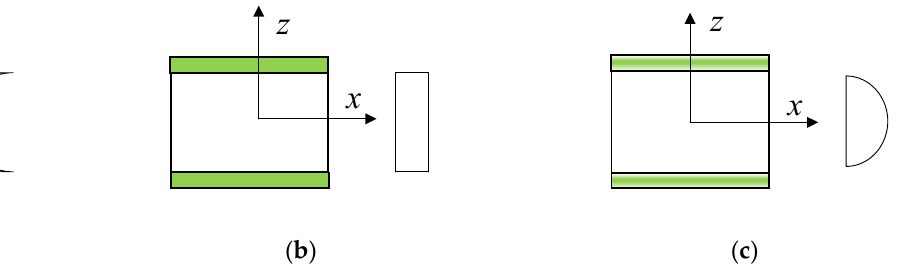
Figure 3. GPL distribution patterns in the surface layer of the plate: ( a ) Pattern X G ; ( b ) Pattern U G ; ( c ) Pattern O G . ( c ) Pattern O G